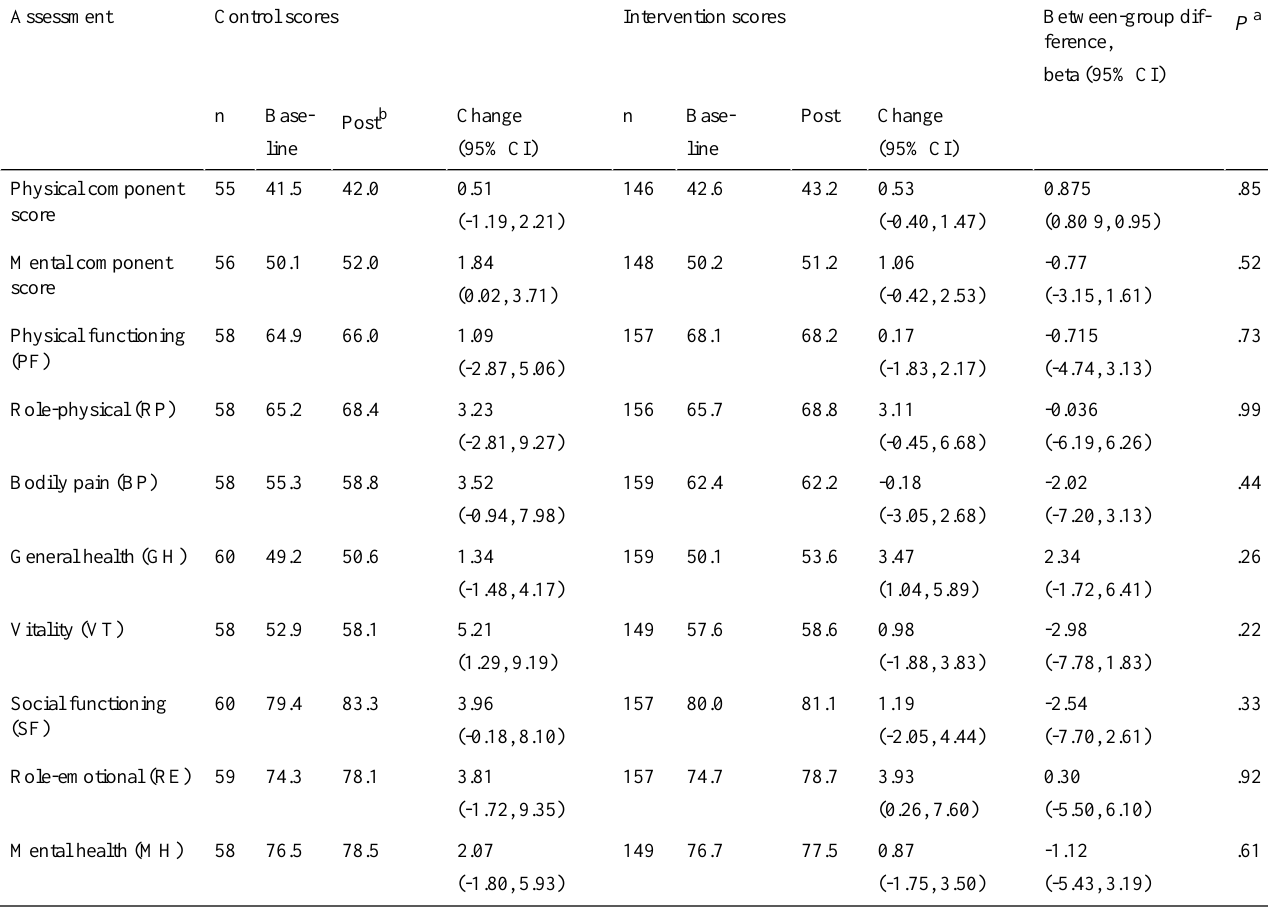
Table 3. The baseline, postintervention, and change scores in the eight dimensions of the health-related quality-of-life assessments and in the two summary scores for diabetes patients.